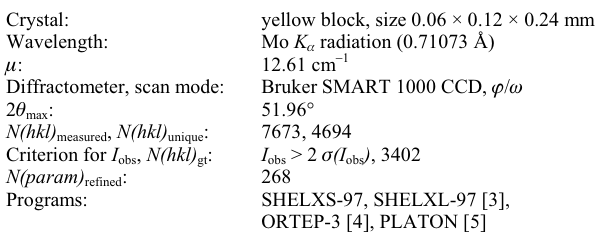
Table 1. Data collection and handling.